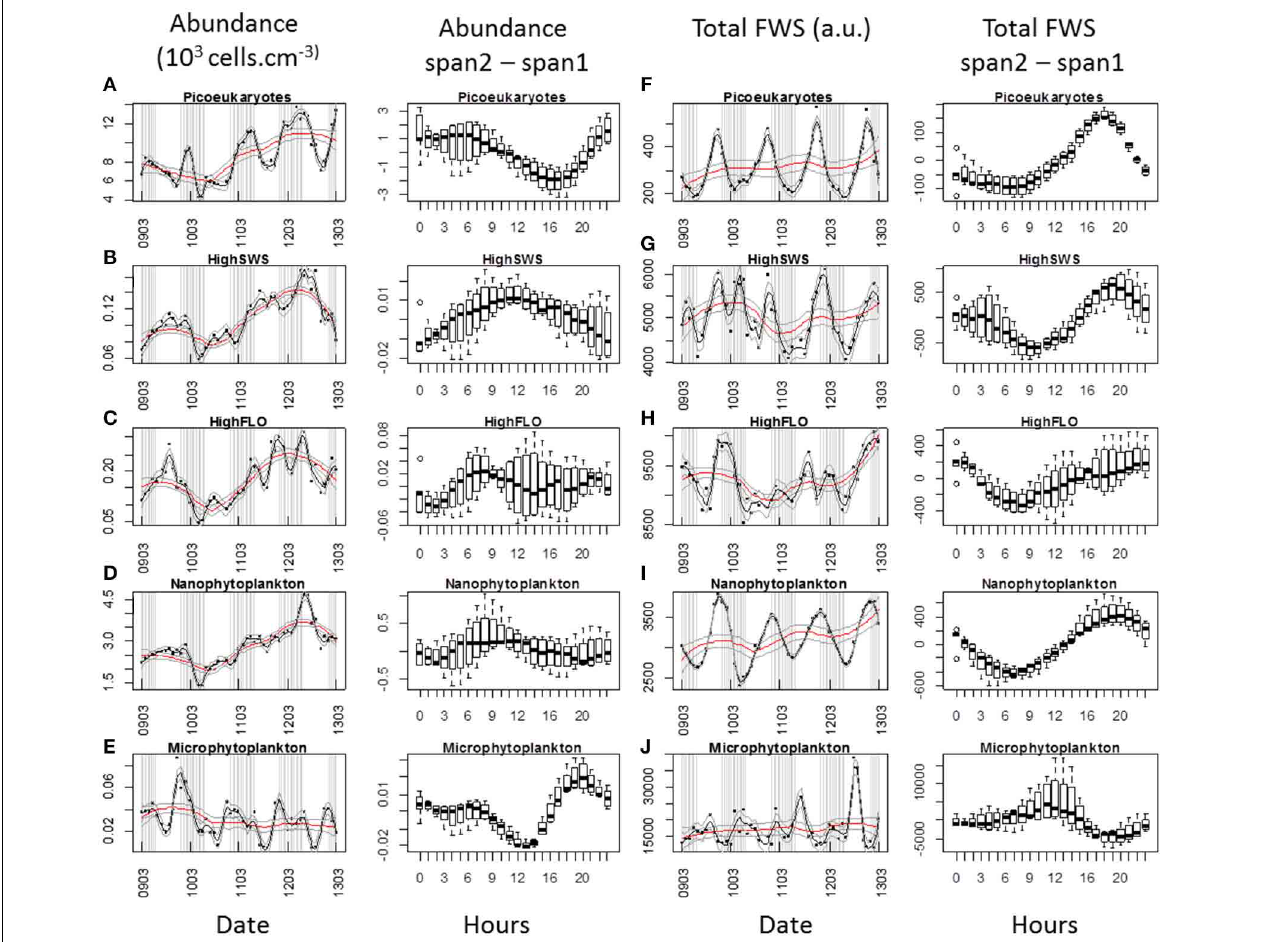
FIGURE 9 | Periodic variations of abundances and average Total FWS signals per cell for each cluster resolved with the CytoSense (except PicoFLO) during the third marked abundance pulse (March 9–13). The corresponding hourly box plots are displayed in parallel. Note the differences between a low span (gray line: span2) and a high span (red line: span1) loess